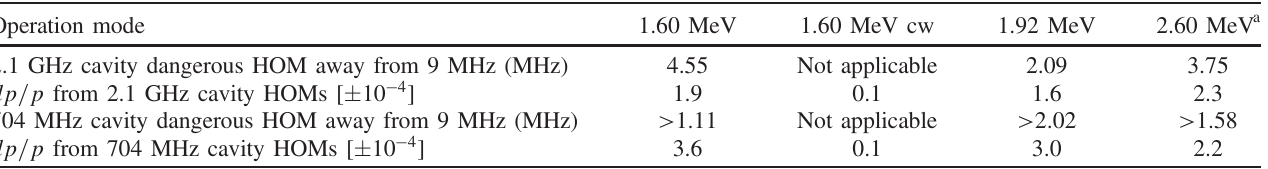
a The dp=p for 2.60 MeV in this table is for the worst case in 24 – 30 bunch